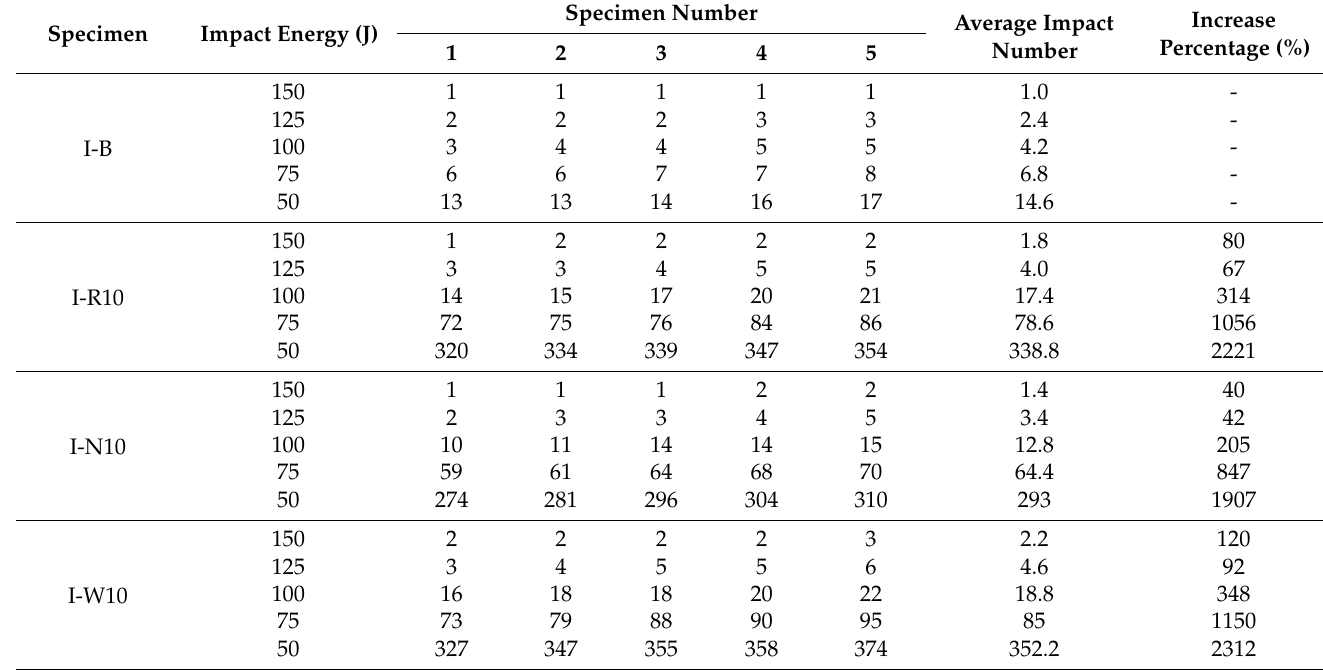
Table 6. Impact test results of benchmark and ECRFC specimens under different